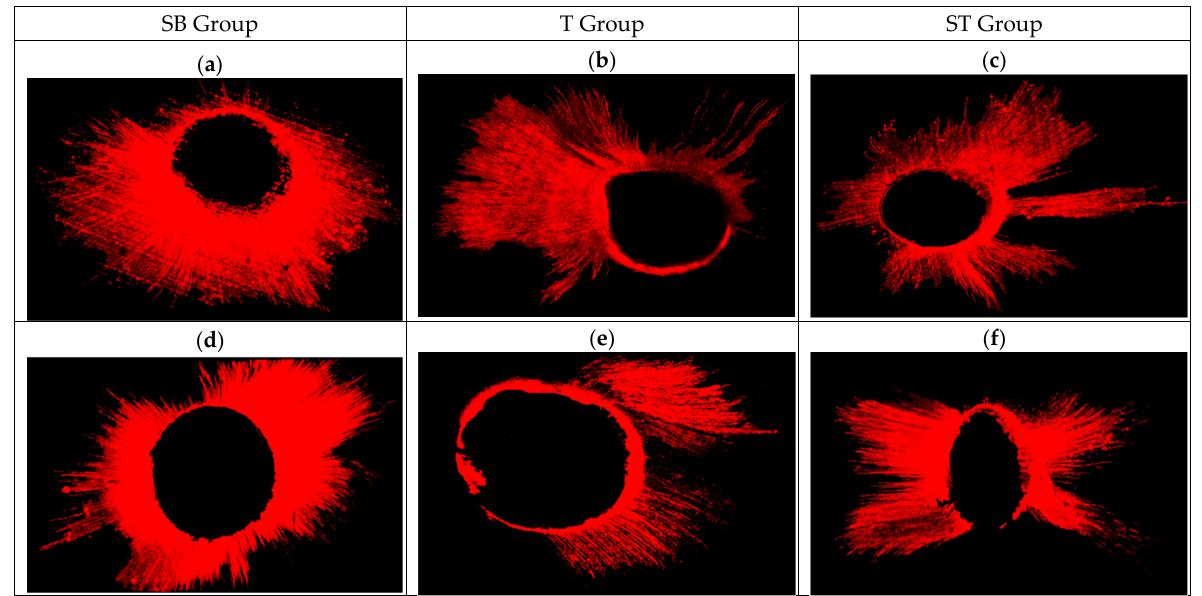
Figure 2. Representative CLSM images at 3 mm level ( a – c ) and 6 mm level ( d – f ) for the three groups. ST registered the highest values of infiltration at both levels (3 mm: 773.2 ± 292.0 μ m; 6 mm: 1156.8 ± 117.9 μ m), reporting statistically significant differences at 6 mm in comparisons with T (3 mm: 594.2 ± 188.5; 6 mm: 708.2 ± 420.3, p = 0.015) and SB (3 mm: 545.91 ± 242.58, 6 mm: 564.5 ± 388.4, p < 0.001) respectively. Although the percentages of sealer penetration were higher for T at 3 mm (0.6 ± 0.1) and ST at 6 mm (0.7 ± 0.1), no statistically significant differences emerged. The ST area of penetration at 6 mm (15,997.1 ± 8566.5 μ m 2 ) resulted in significantly higher values than those observed with T (8092.9 ± 6115.0, p = 0.0282) and SB (7696.0 ± 7585.4, p = 0.0282). At 3 mm, no statistically significant differences emerged. All results are reported in Table 1.